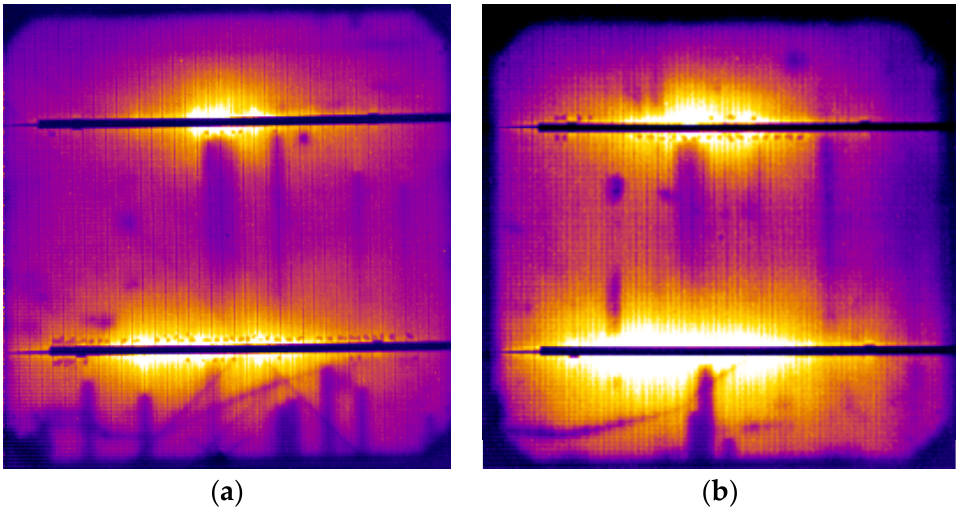
Figure 7. ( a , b ) EL images (pseudocolour) of two cells of an M55 module showing darker spots at the delaminated areas around the busbar. Module forward biased at 19.5 V and 19.8 V, respectively.